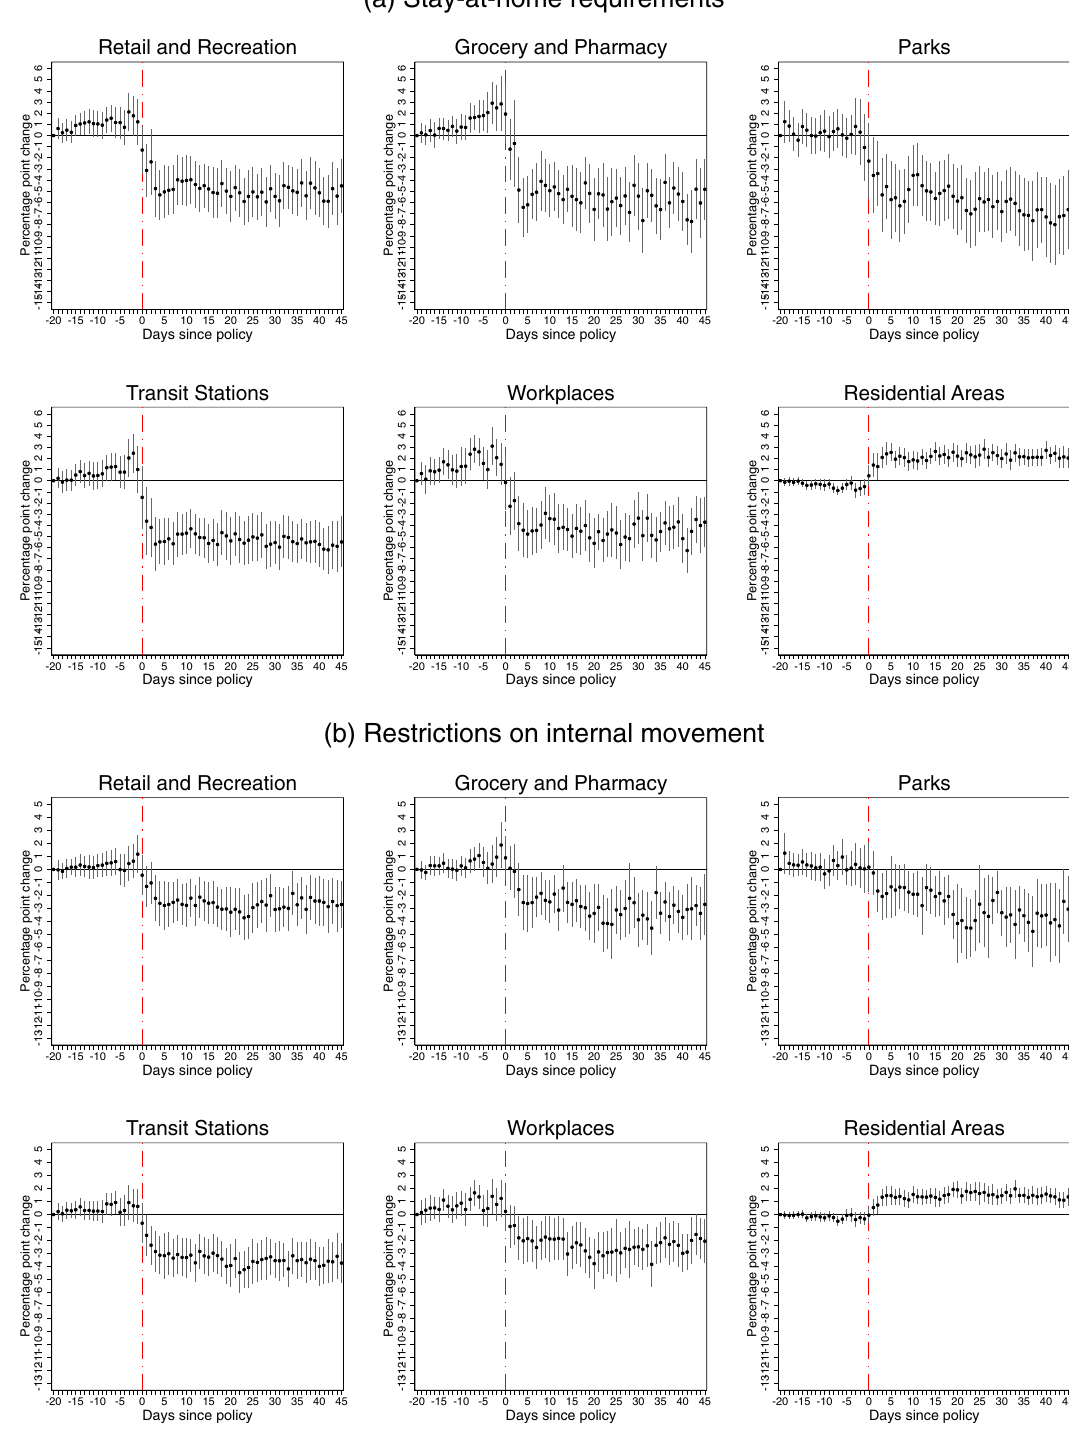
Figure 5. Effects of stay-at-home requirements (panel a ) and restrictions on internal mobility (panel b ) on Google mobility